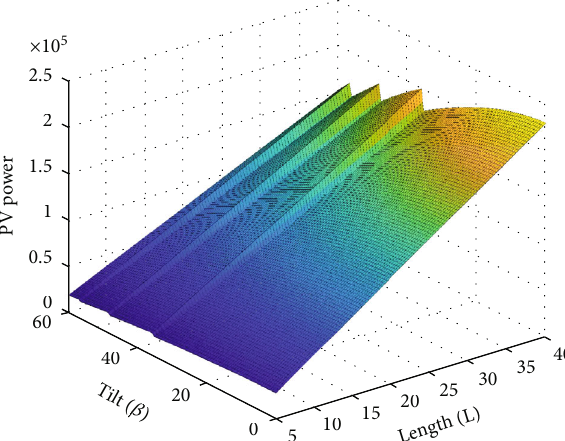
Figure 8: Length of SPV row ( L ) e ff ect on SPV